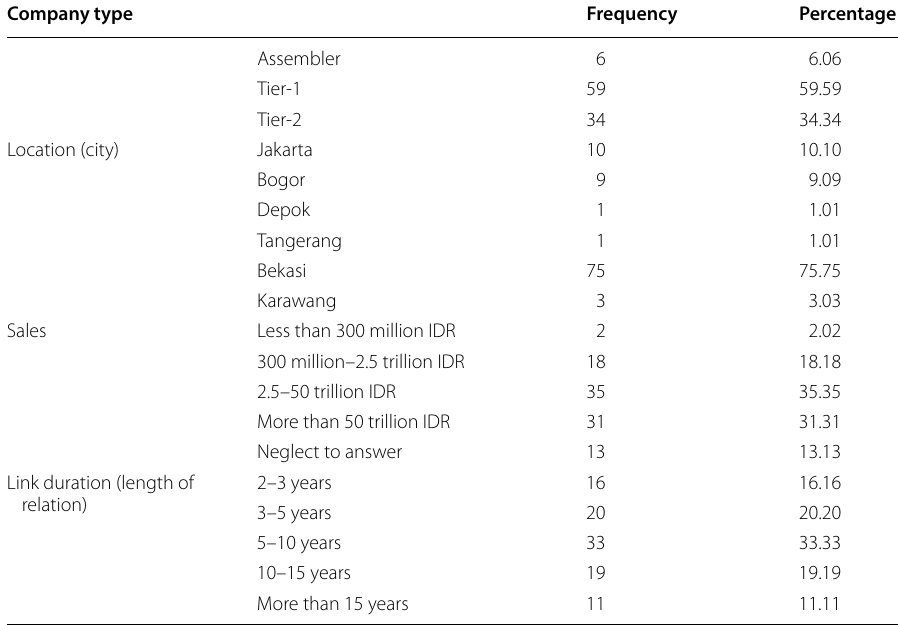
Table 2 Respondents’ profiles. Source : Author Field Research Company